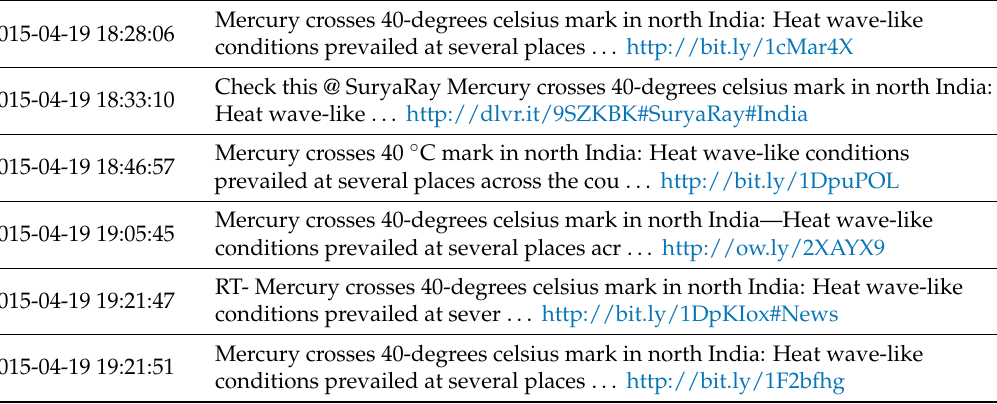
Table 3. Some of the tweets containing the phrase “heat wave India” in April 2015. The heat wave of 2015 started in April and reached its peak in